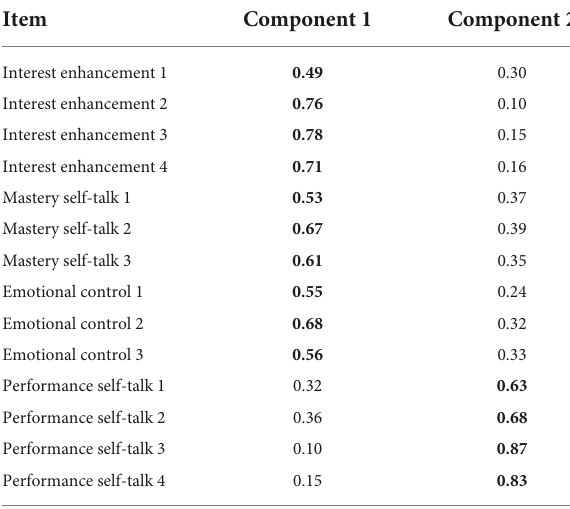
TABLE 2 Principal component analysis factor loadings for motivational